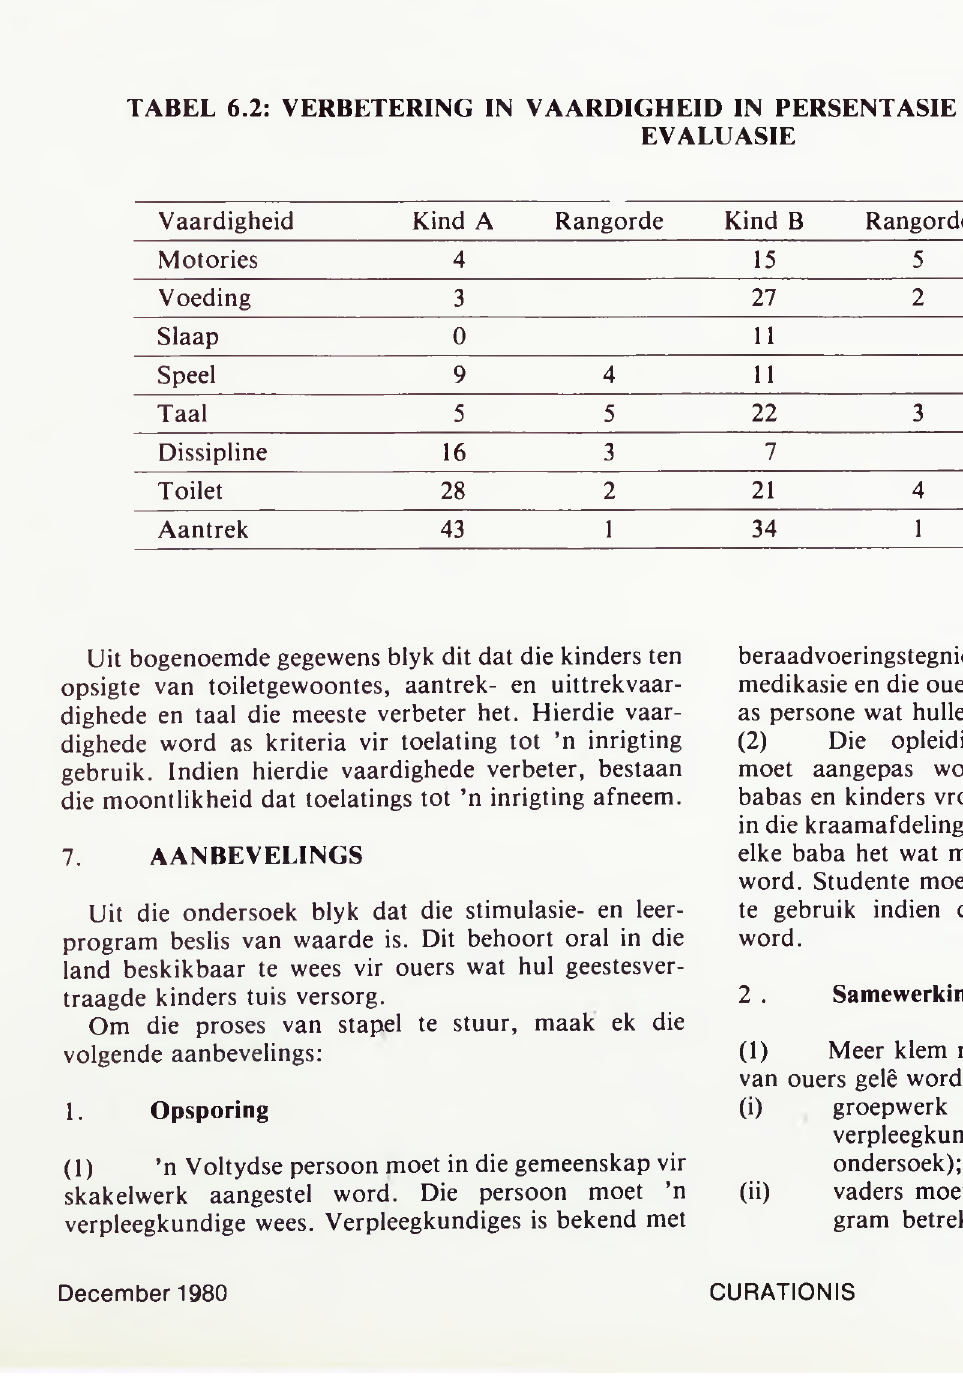
TABEL 6.2: VERBETERING IN VAARDIGHEID IN PERSENTASIE UITGEDRUK NA